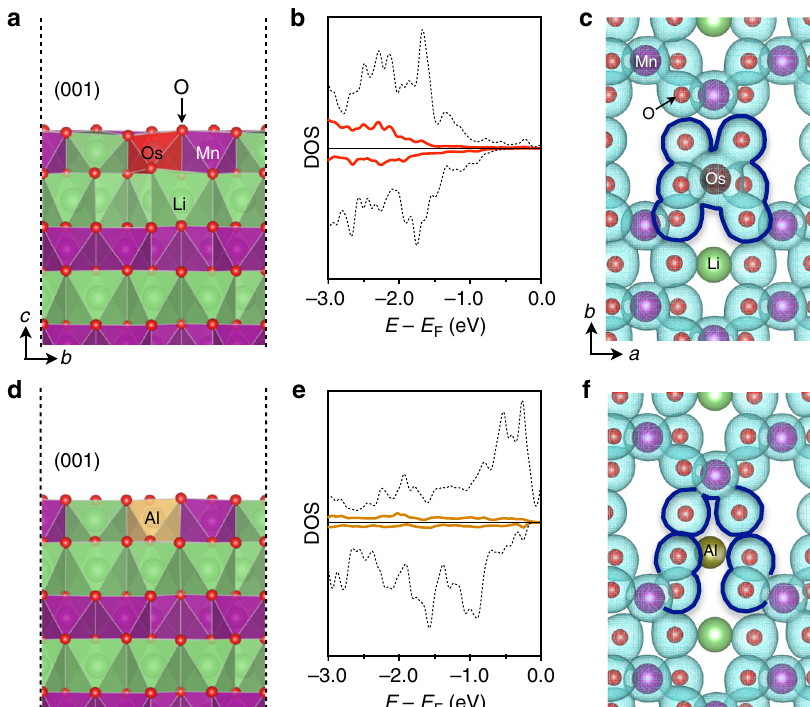
Fig. 4 Electronic structure of surface Os and Al dopants, highlighting their bonding to neighboring oxygen ions. The Os doping on the (001) surface ( a ) presents strong hybridization between oxygen p -orbitals (black dashed line in b ) and the surface defect d -orbitals (red solid lines in b ). The hybridization is further illustrated by the charge (cyan isosurface lines, here iso-surface levels of c and f are 0.1 Å − 3/2 ) sharing between the surface defect atom and neighboring oxygen atoms ( c ). In contrast, Al doping on the (001) surface ( d ) exhibits weak hybridization ( e ), which is evidenced in charge separation between the defect atom and its neighboring oxygen ions ( f )